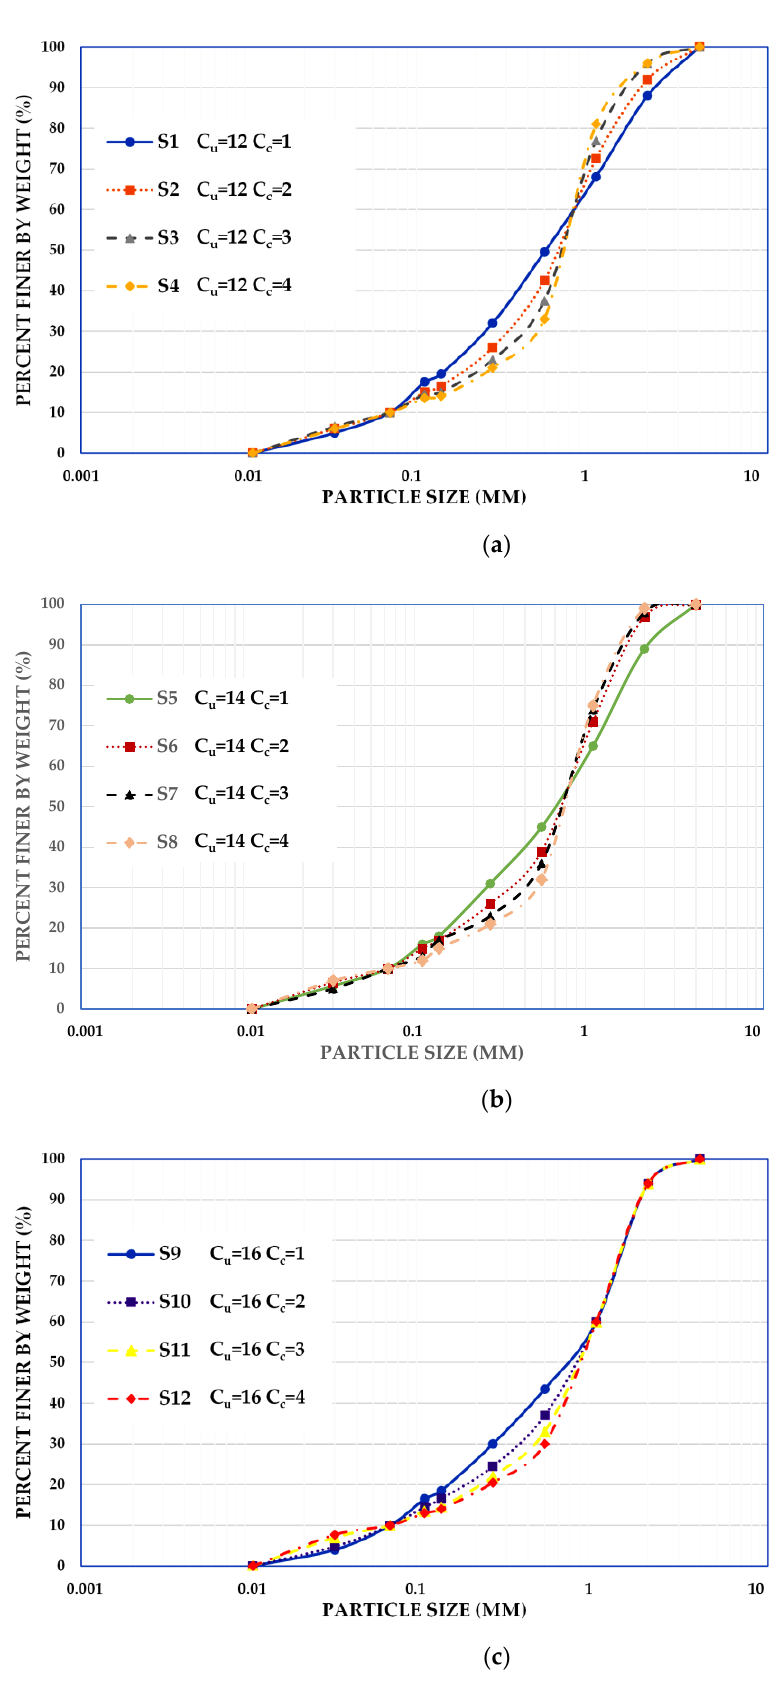
Figure 1. Tested grain size distribution curves for the group of sands with C u equal to ( a ) 12, ( b ) 14, and ( c ) 16.